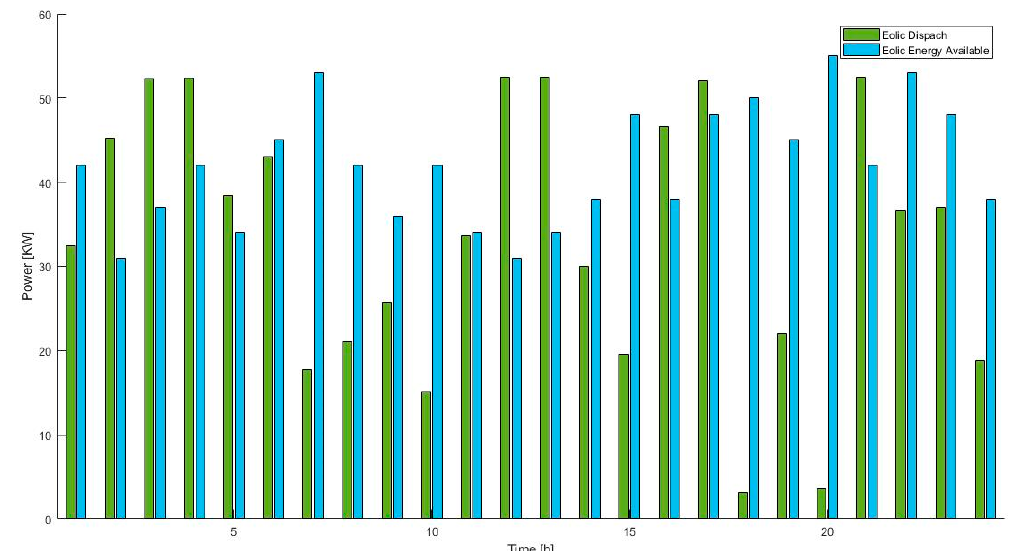
Figure 12. Availability and dispatch of the wind energy system of the MG when the storage system is at the end of its useful life.